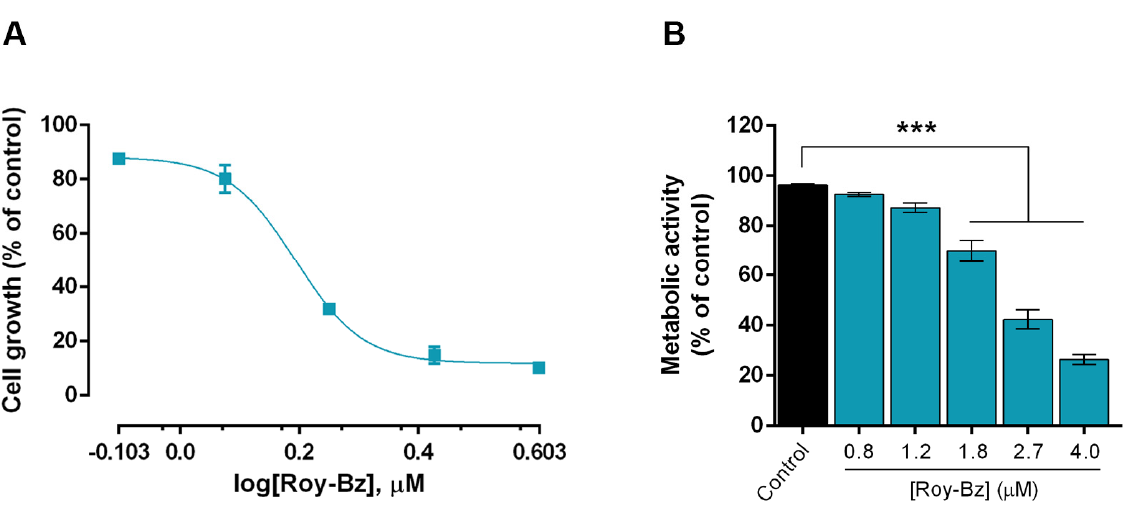
Figure 2. Roy-Bz has cytotoxic effect on colon cancer cells by decreasing their metabolic activity. ( A , B ) HCT116 cells were treated with increasing concentrations (0.8 to 4.0 µ M) of Roy-Bz or vehicle (DMSO), for 48 h. In ( A ), the dose-response curve for the growth of HCT116 cells was obtained from the SRB assay (IC 50 value of 1.65 ± 0.15 µ M). Data are mean ± SEM of four independent experiments; growth obtained with vehicle was set as 100%. In ( B ), metabolic activity was determined by resoru- fin fluorescence measurement after 360 min incubation, using resazurin assay. Data are expressed as percentage of vehicle and are mean ± SEM of three independent experiments. Statistical analysis was carried out with a one-way ANOVA test followed by a Dunnett’s post hoc test; *** significantly different from control (cells treated with vehicle) with p < 0.001.